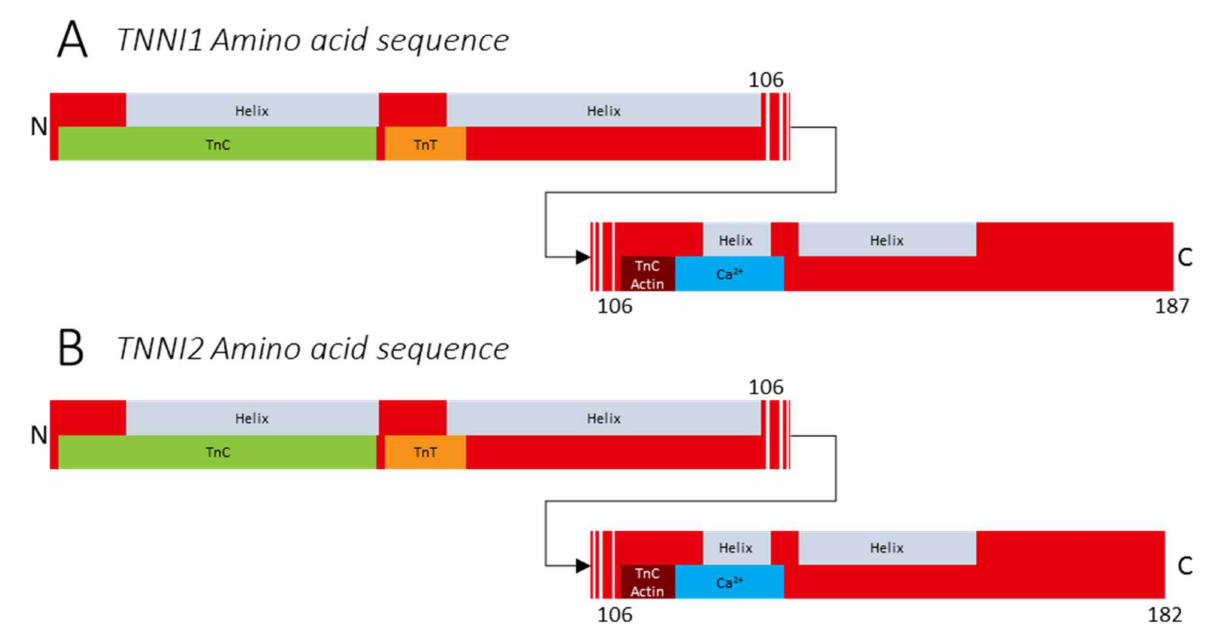
Figure 3. Protein structure of ( A ) TNNI1 (UniProt (P19237, TNNI1_Human)) and ( B ) TNNI2 (UniProt (P48788,